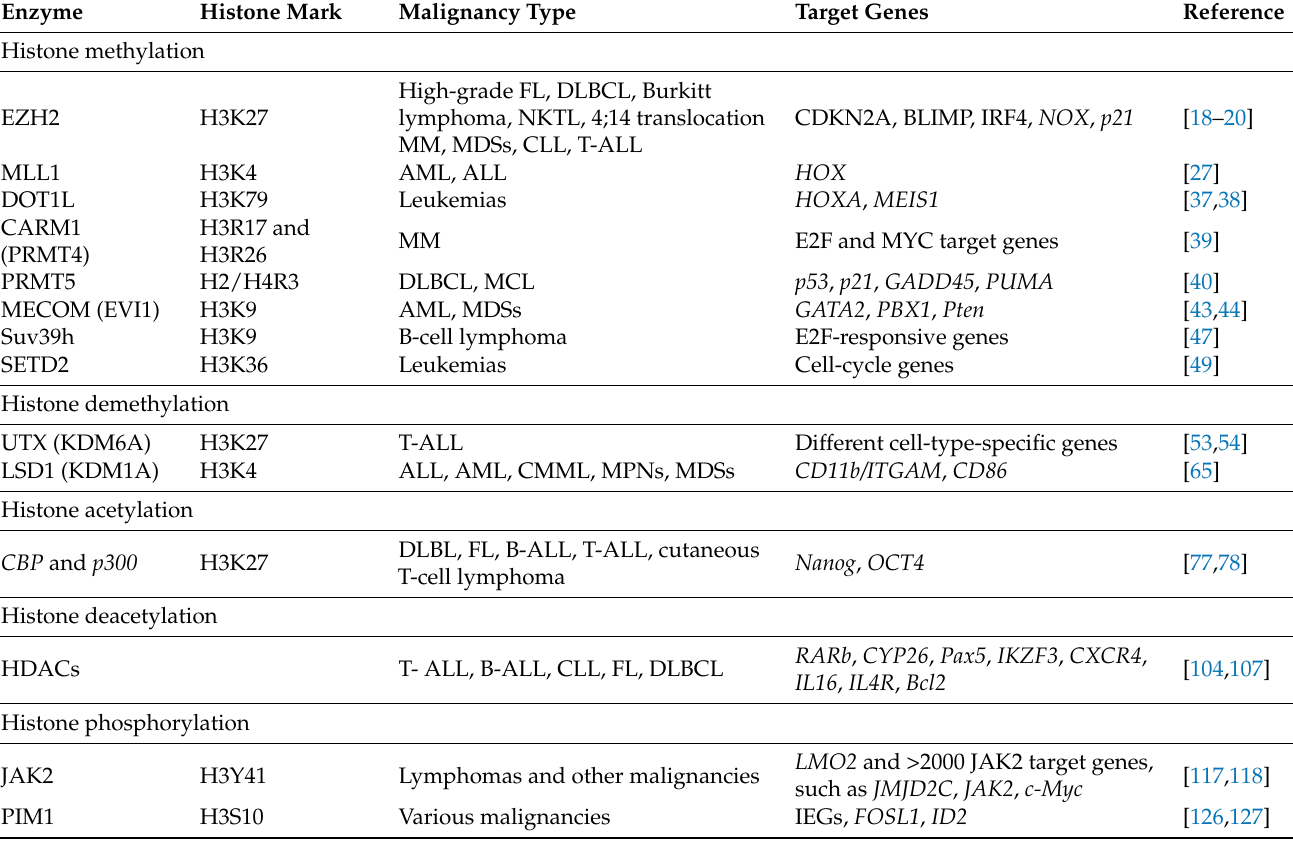
Table 1. Histone-modifying enzymes involved in hematological cancers.